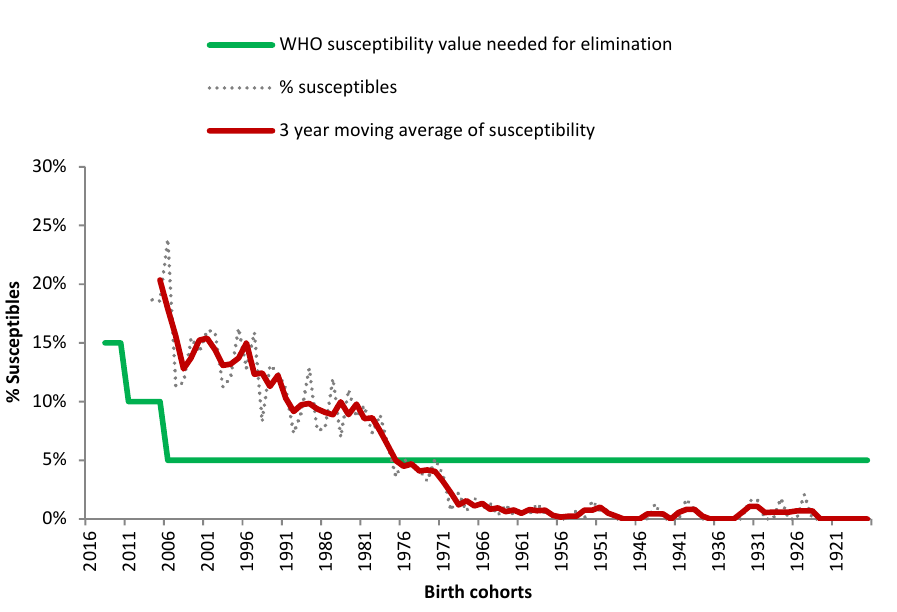
Figure 2. Proportion of susceptible persons by birth cohort, 3-year moving averages and WHO recommended susceptibility values needed for elimination (birth cohorts 1917–2016). Table 2. Measles susceptibility levels by birth cohort and age group and WHO recommended maximum susceptibility values necessary for